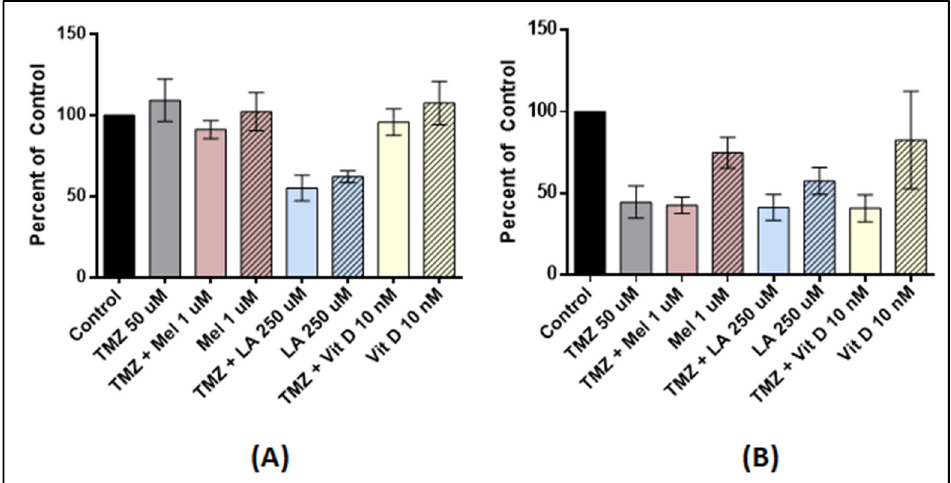
Figure 2. Cell proliferation of U87 ‐ MG and MU1454 measured via the MTT assay after serial (“cycled”) 72 h treatments with antioxidants (Vitamin D [Vit D], Lipoic Acid [LA], or Melatonin [Mel]) followed by TMZ 50 uM. Dose of TMZ is constant and the doses of antioxidants are indicated on the graph. ( A ) U87 ‐ MG cells after treatment with Melatonin at 1 uM, Lipoic acid at 250 uM, and Vitamin D at 10 nM with or without TMZ at 50 uM. ( B ) MU1454 proliferation after treatment with melatonin at 1 uM, Lipoic acid at 250 uM, and Vitamin D at 10 nM with or without TMZ at 50 uM. Error bars represent the 95% confidence interval.